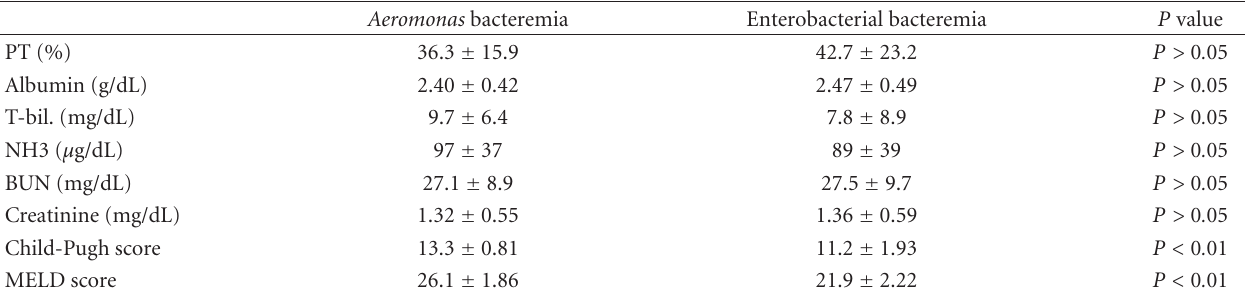
Table 3: Comparison of laboratory findings in the two